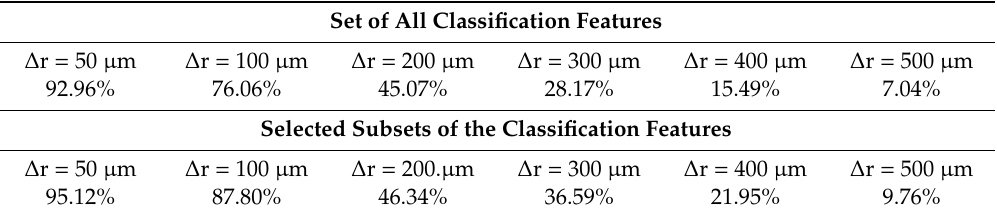
Table 2. The percentage of classification features extracted from the decentered Fresnel patterns statistically comparable with the features of the centered Fresnel patterns for di ff erent sets of